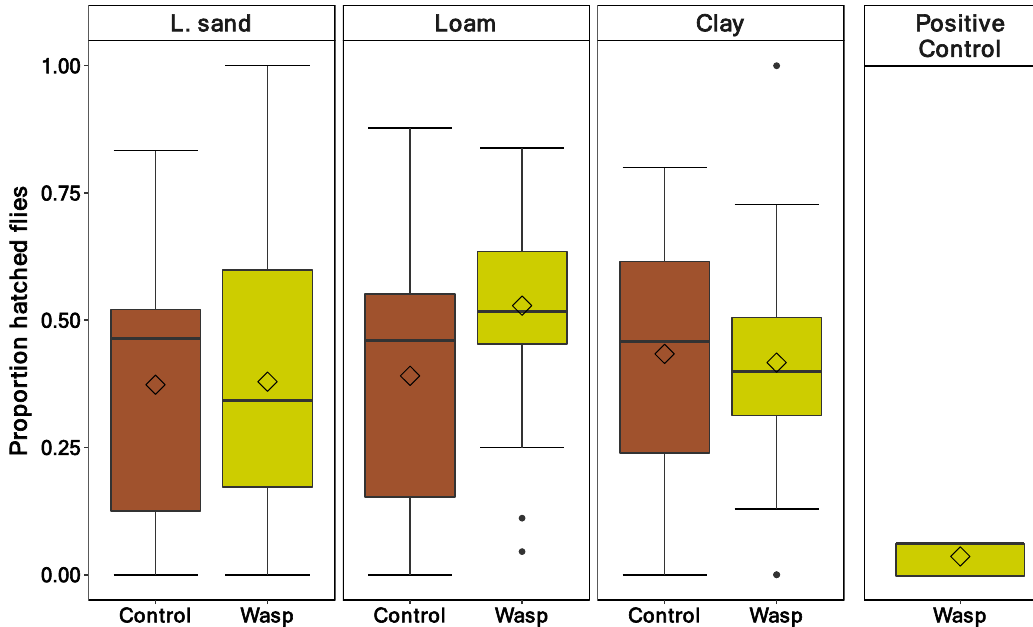
Figure 5. Proportion of hatched Drosophila suzukii flies from the three soil types (loamy sand, loam, and clay). Pupae were either exposed to the parasitoid wasp (Wasp) or not (Control). The fourth panel displays the number of hatched D. suzukii in the positive control, where the wasps had free access to the pupae in a petri dish (wasp: n = 57, control: n = 39, positive control: n =